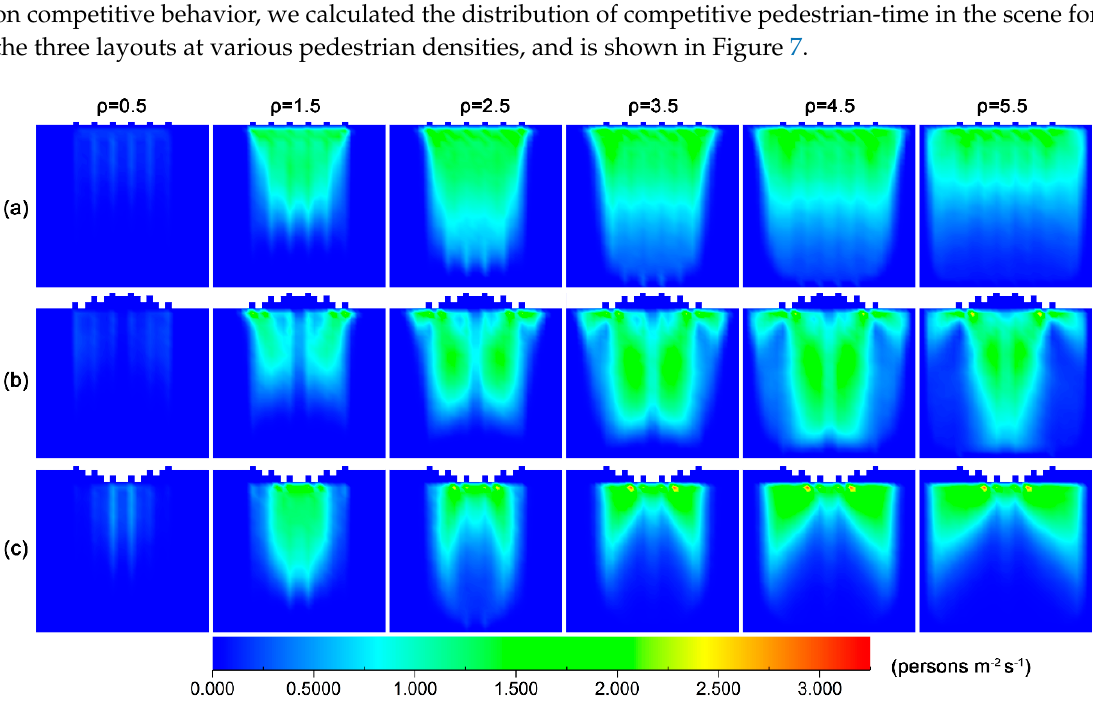
Figure 7. Distribution of competitive pedestrian-time at different pedestrian densities for the three layouts of inspection points: ( a ) parallel, ( b ) convex and ( c ) concave. The checking failure probability and delay are 0.08 and 3 s, respectively. The unit of pedestrian density is persons/m 2 .